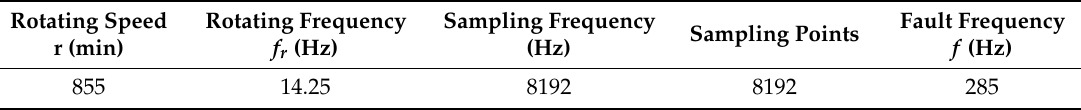
Table 5. Experimental parameters of